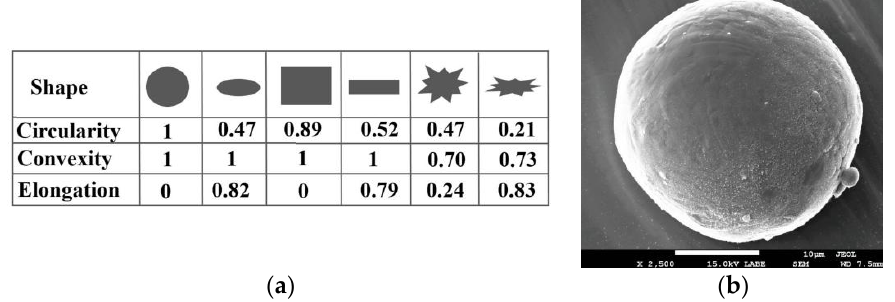
Figure 6. ( a ) Shape parameters used to investigate the 316L particles and their value significance; ( b ) SEM image of 316L particle.